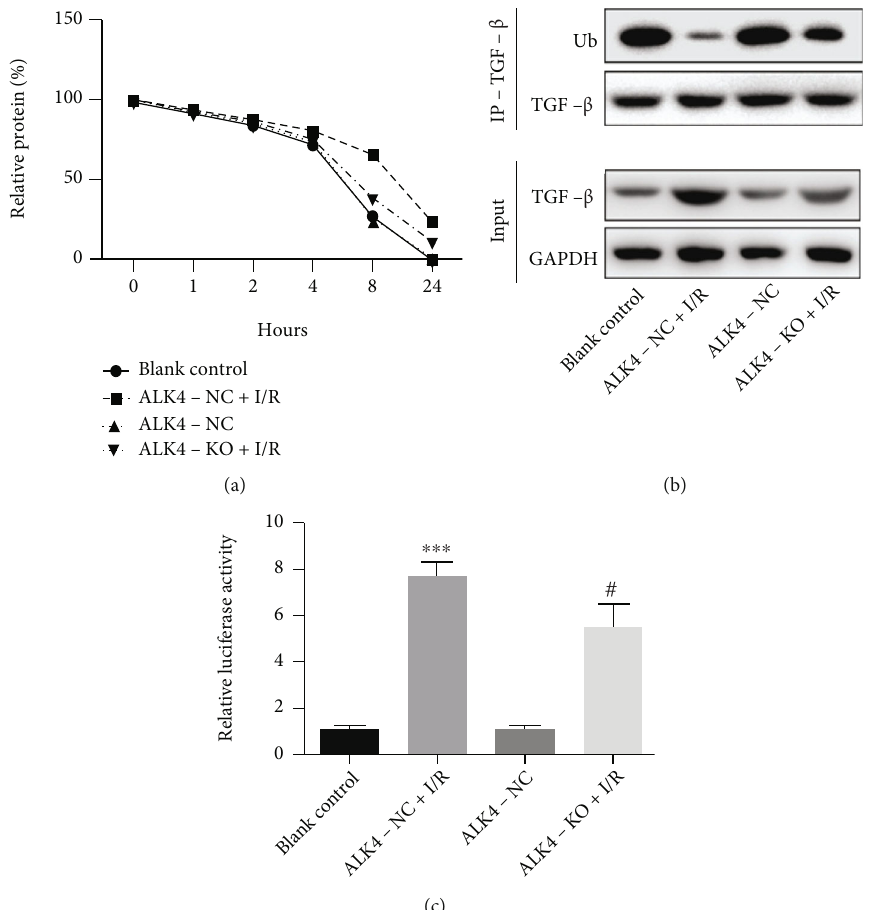
Figure 6: E ff ects of ALK4 on TGF- β protein stability and transcriptional activity in the H9C2 cells experiencing I/R injury. (a) CHX was used to inhibit protein synthesis. The cells were lysed and total proteins were extracted for Western blotting with anti-TGF- β antibody. (b) Coimmunoprecipitation assay of Ub protein expression. (c) Luciferase report assay was carried out to assess the transcriptional activity of TGF- β promoter. Data are presented as mean ± SD . ∗ P < 0 : 05 , ∗∗ P < 0 : 01 , and ∗∗∗ P < 0 : 001 , ALK4-NC+I/R group vs. ALK4- NC group. # P < 0 : 05 , ## P < 0 : 01 , and ### P < 0 : 001 , ALK4-KO+I/R group vs. ALK4-NC+I/R